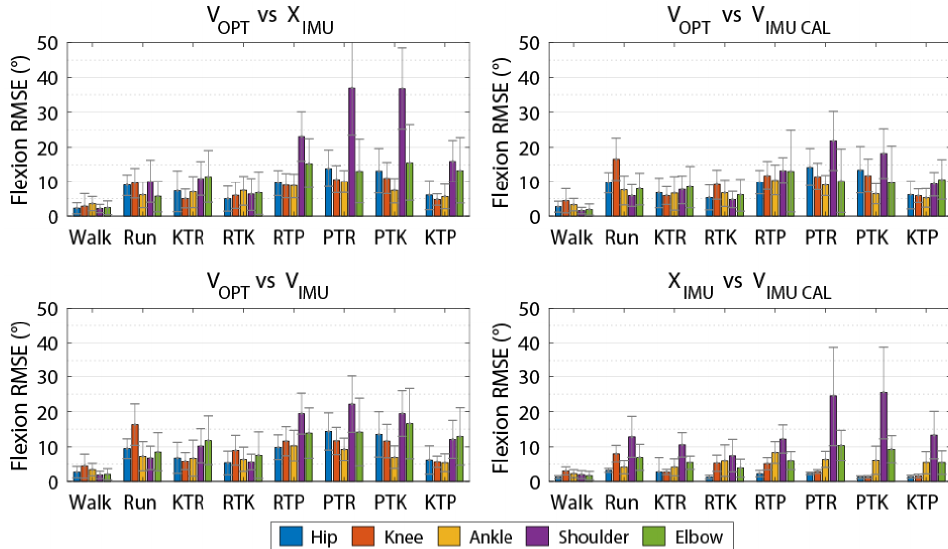
Figure 4. Joint flexion/extension angle RMSE values for each task for joint angles calculated from optical data using Visual3D (V OPT ), IMU data using Visual3D (V IMU ), IMU data using Visual3D with calibration to align anatomical coordinate systems with optical model (V IMU-CAL ), and IMU data using MVN Analyze (X IMU ). Presented data are averaged between left and right sides across all participants and repetitions for each trial. RTK = run-to-kneel; RTP = run-to-prone; KTR = kneel-to-run; PTR = prone-to-run; KTP = kneel-to-prone; PTK = prone-to-kneel. Comparing OPT angles calculated in Visual3D with IMU angles calculated in MVN Analyze flexion/extension, 9.30° (SD = 5.54) for ab/adduction, and 17.8° (SD = 15.7) for axial rotation. RMSE upper limb differed considerably between the two methods, with a mean RMSE of 35.6° (SD = 25.1). Table 3. Mean RMSE values V OPT vs. X IMU.